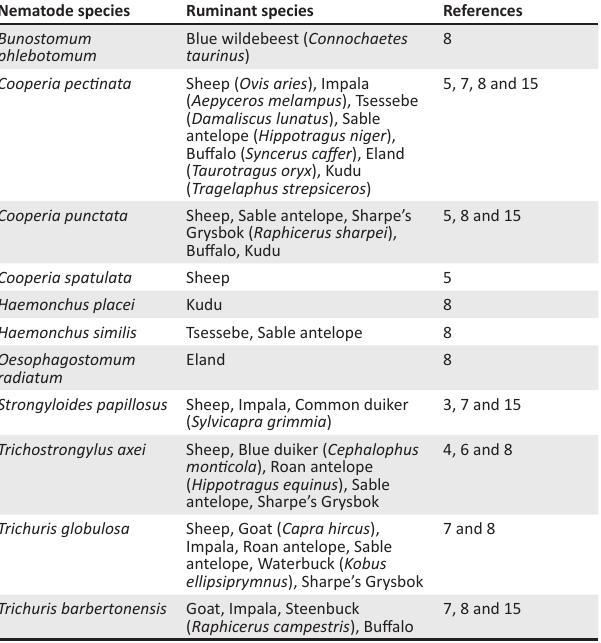
TABLE 2: Checklist of cattle gastrointestinal nematode species reported in other domestic and wild ruminants in Zimbabwe. Nematode